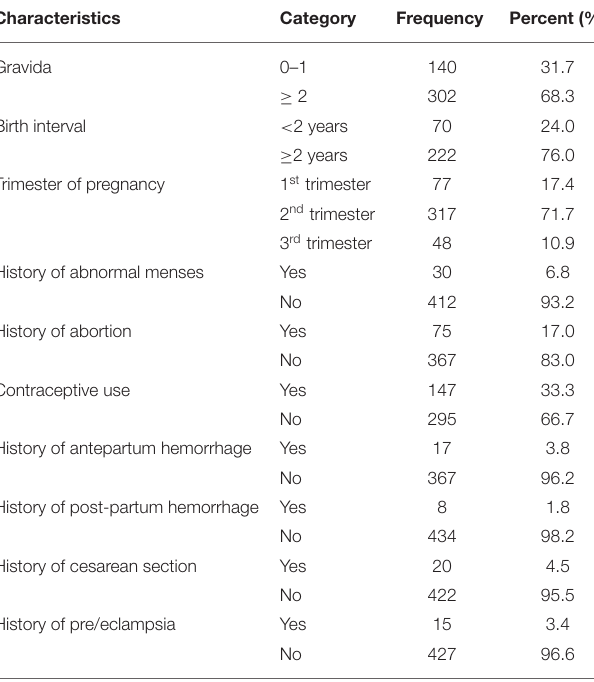
TABLE 3 | Obstetrics and gynecologic characteristics of respondents attending ANC in a University hospital in Eastern Ethiopia, 2021 ( n = 442). Characteristics